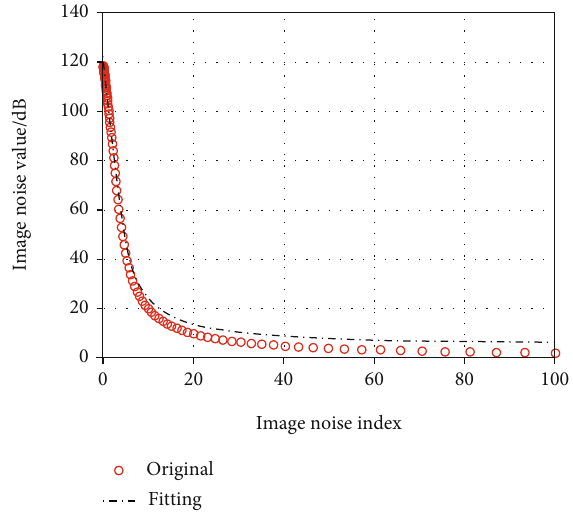
Figure 4: Denoising e ff ect curve distribution at di ff erent noise points of the